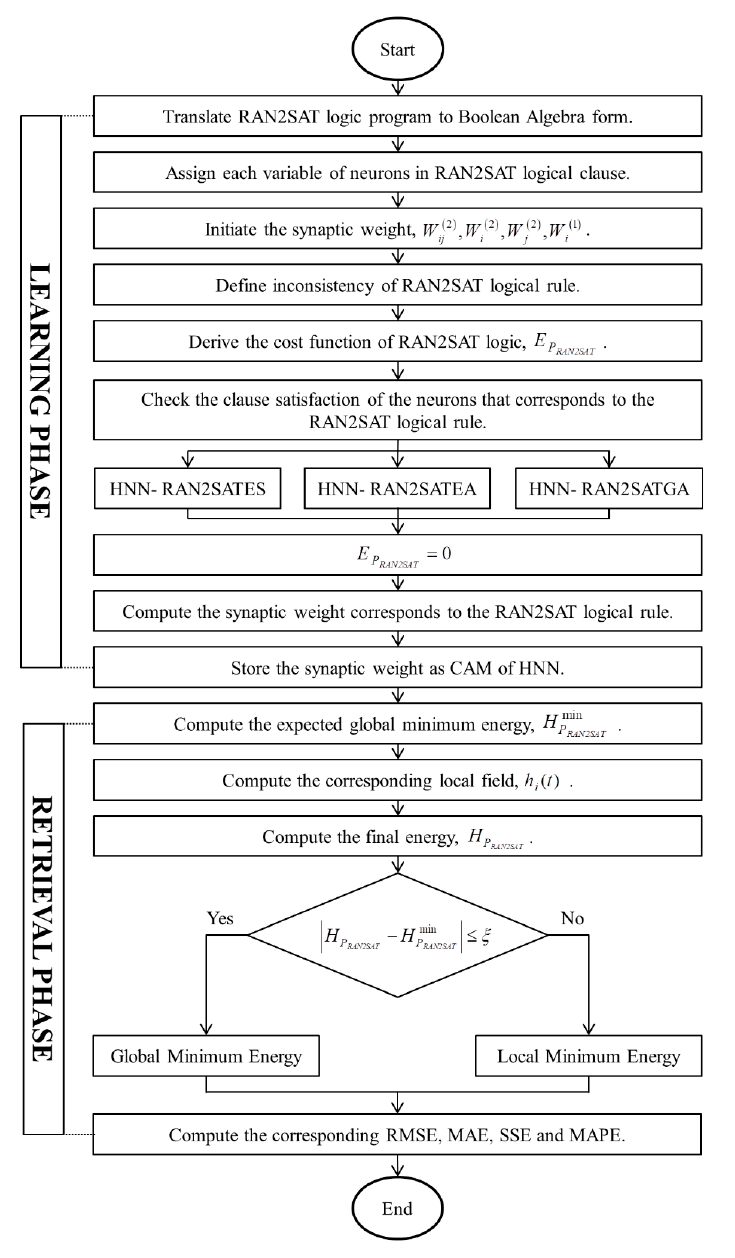
ff erent HNN-RAN2SAT Figure 1. Implementation of different HNN-RAN2SAT models. Figure 1. Implementation of di